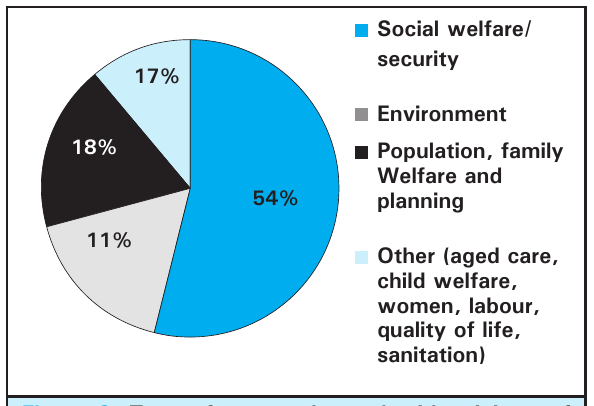
Figure 6. Type of sectors lumped with ministry of